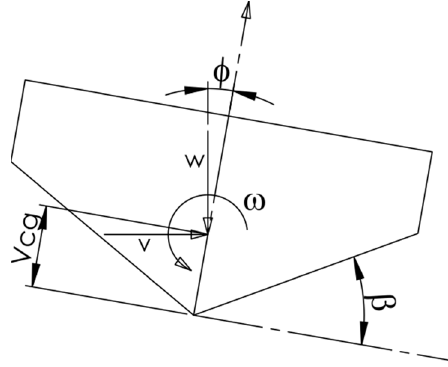
Figure 3. Impact with three degrees of freedom.